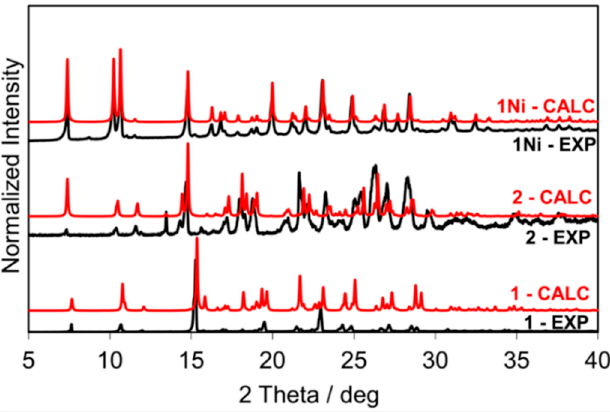
Figure 3. From bottom to top: PXRD patterns of 1 , 2 , and 1Ni (calculated powder patterns in red, experimental powder patterns in black).